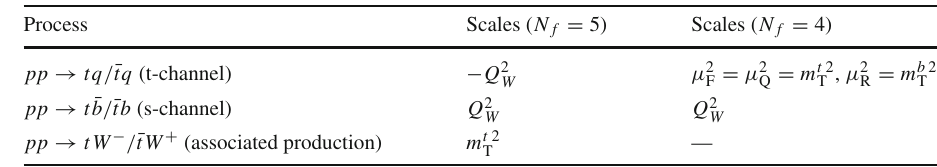
Table 1 Scale choices for all three single-top production channels